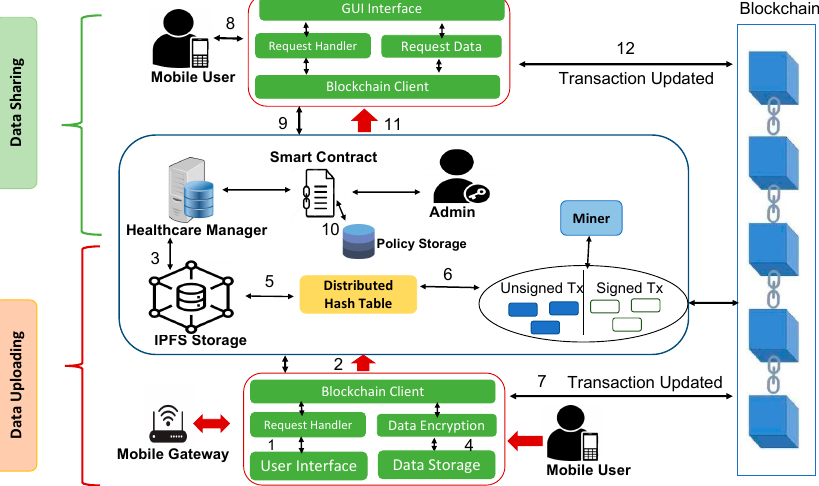
Figure 6. The Proposed Method Data Uploading and Sharing.